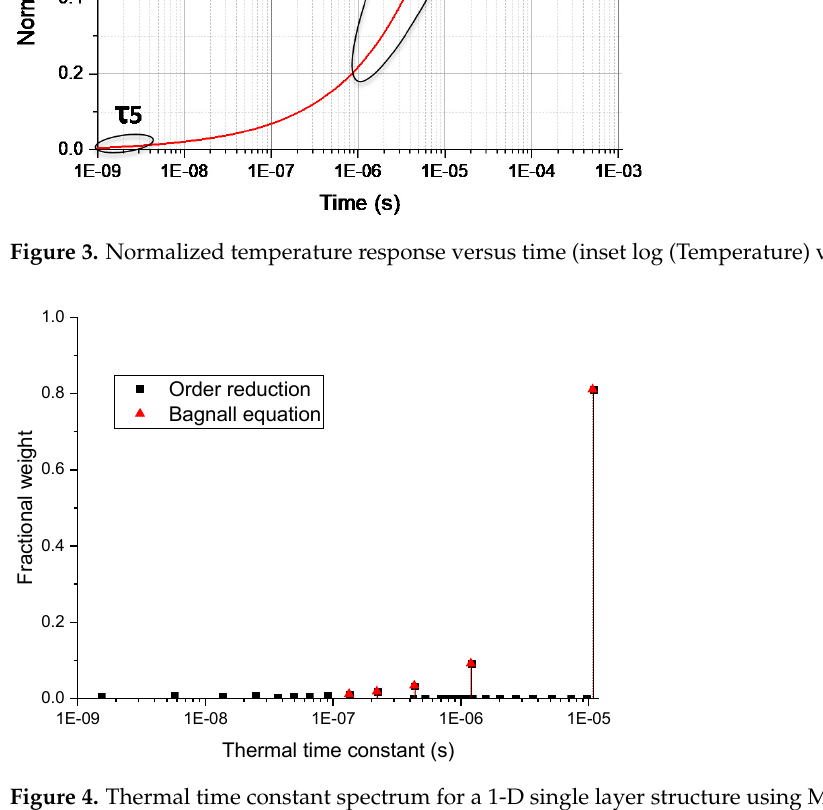
Figure 4. Thermal time constant spectrum for a 1-D single layer structure using MOR in black and Equation (9) in red (analytical solution).